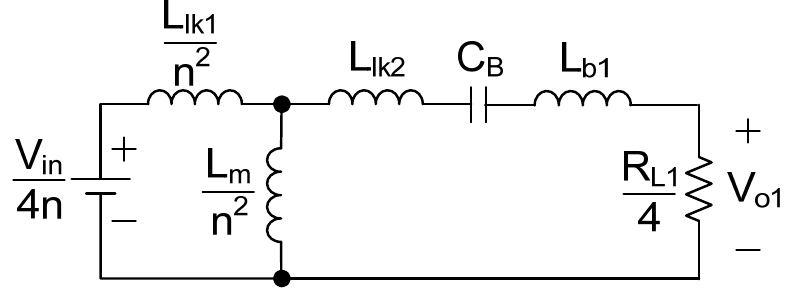
Figure 18. Simplified equivalent circuit of secondary side converter.